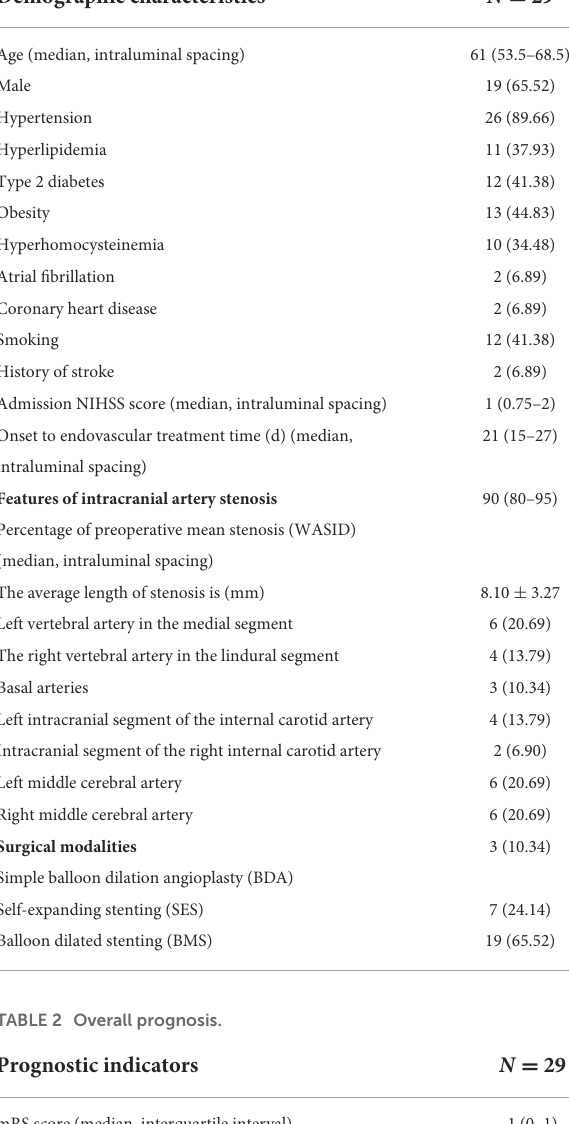
TABLE 1 Demographic features, intracranial artery stenosis characteristics, and surgical modalities.